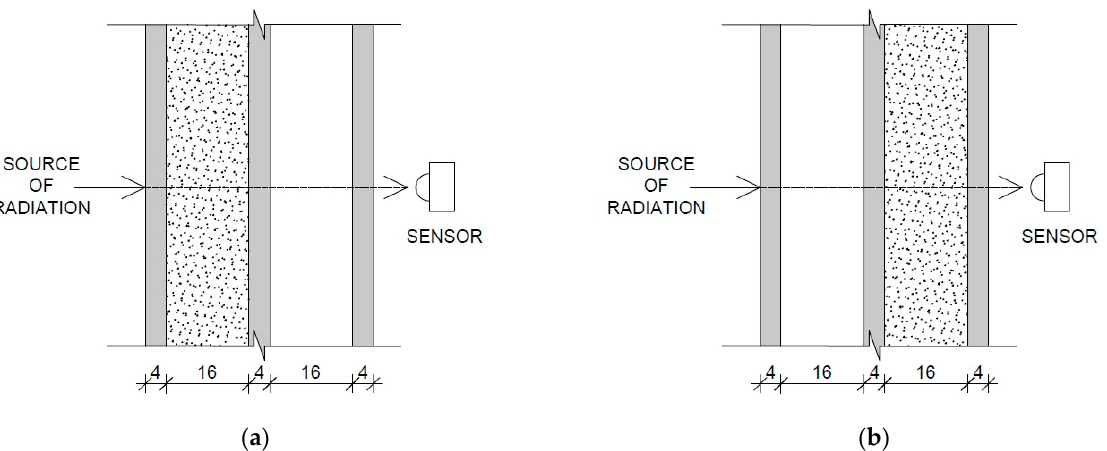
Figure 2. Two configurations of PCM layer towards solar radiation, ( a )—case A (from the front side towards radiation), ( b )—case B (from the backside towards radiation), dimensions are given in mm.